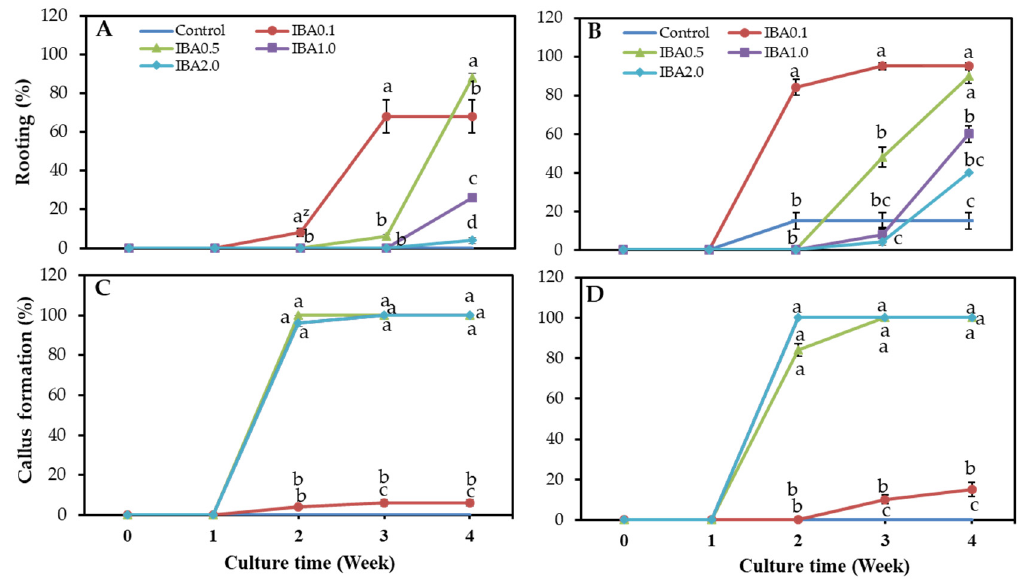
Figure 1. Rates of rooting and callus formation in the apple rootstocks M9 ( A , C ) and M26 ( B , D ) on Murashige and Skoog (MS) medium containing 0, 0.5, 1.0, or 2.0 mg·L − 1 IBA. z Different letters indicate significant differences ( p < 0.05) between treatments at each timepoint according to Duncan’s multiple range test.